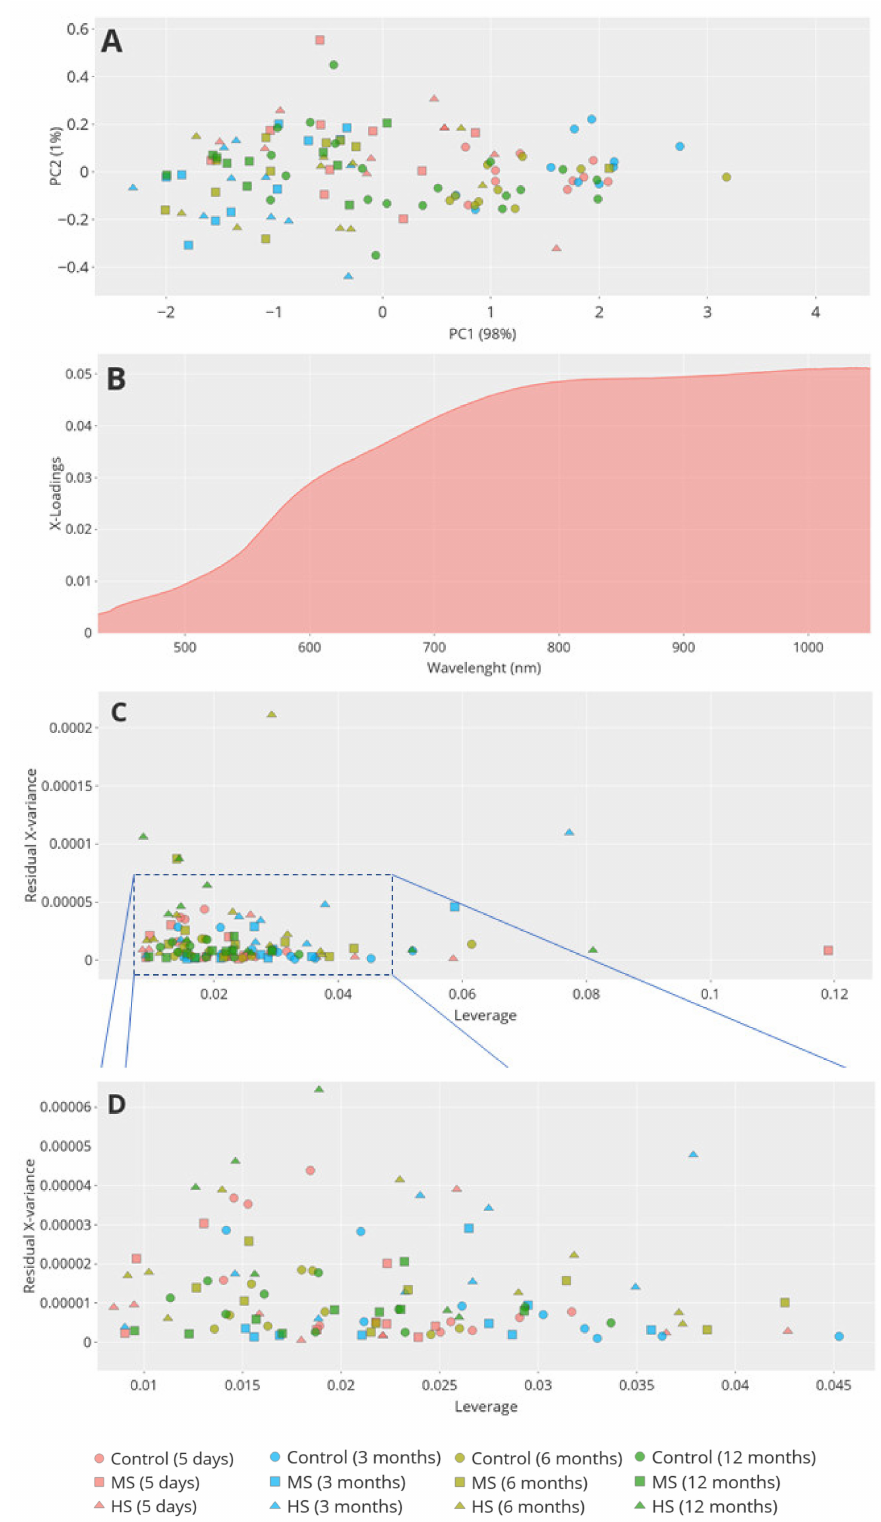
Figure 3. The PCA results overview for soil reflectance of 120 samples with wavelength range 430–1050 nm. ( A ) PC1 and PC2 score plot, ( B ) spectral loadings plot, ( C ) residual spectral variance, and ( D ) Figure 3C zoomed area. Abbreviations: unburned control (CON); moderate fire severity (MS); high fire severity